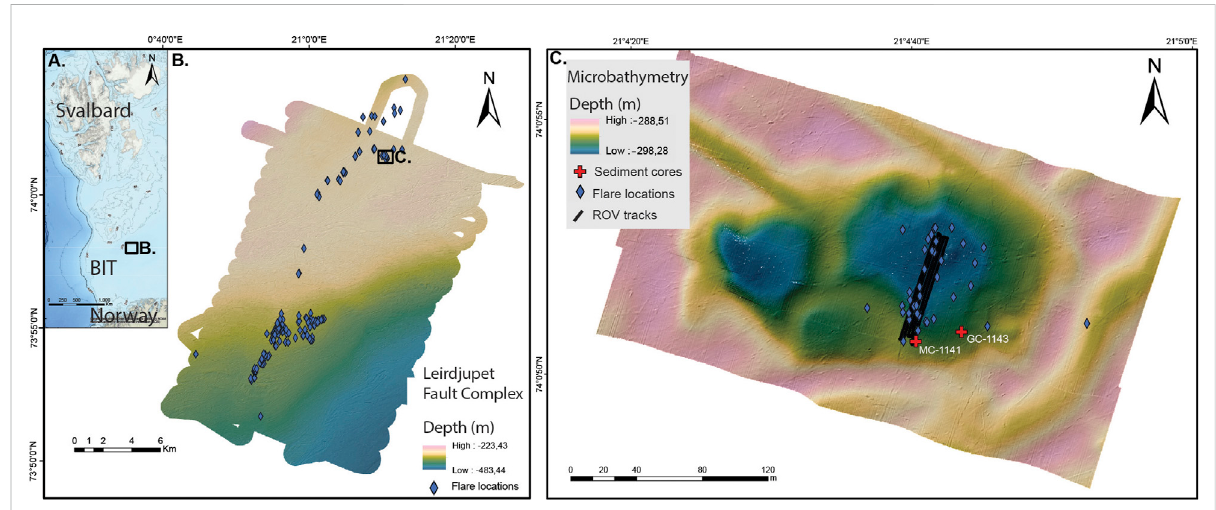
FIGURE 1 (A) Bathymetric map of the Western Barents Sea showing the location of the study area (box). (B) Distribution of gas fl ares (polygons) at Leirdjupet Fault Complex and location of the pockmark site (box). (C) Microbathymetry of the pockmark site showing ROV tracks used for the photogrammetry survey in the methane-derived carbonate area, location of fl ares and two sediment cores previously reported in Argentino et al. (2021). BIT = Bear Island Trough. This color scale is accessible for people with color-vision de fi ciencies (Crameri et al.,